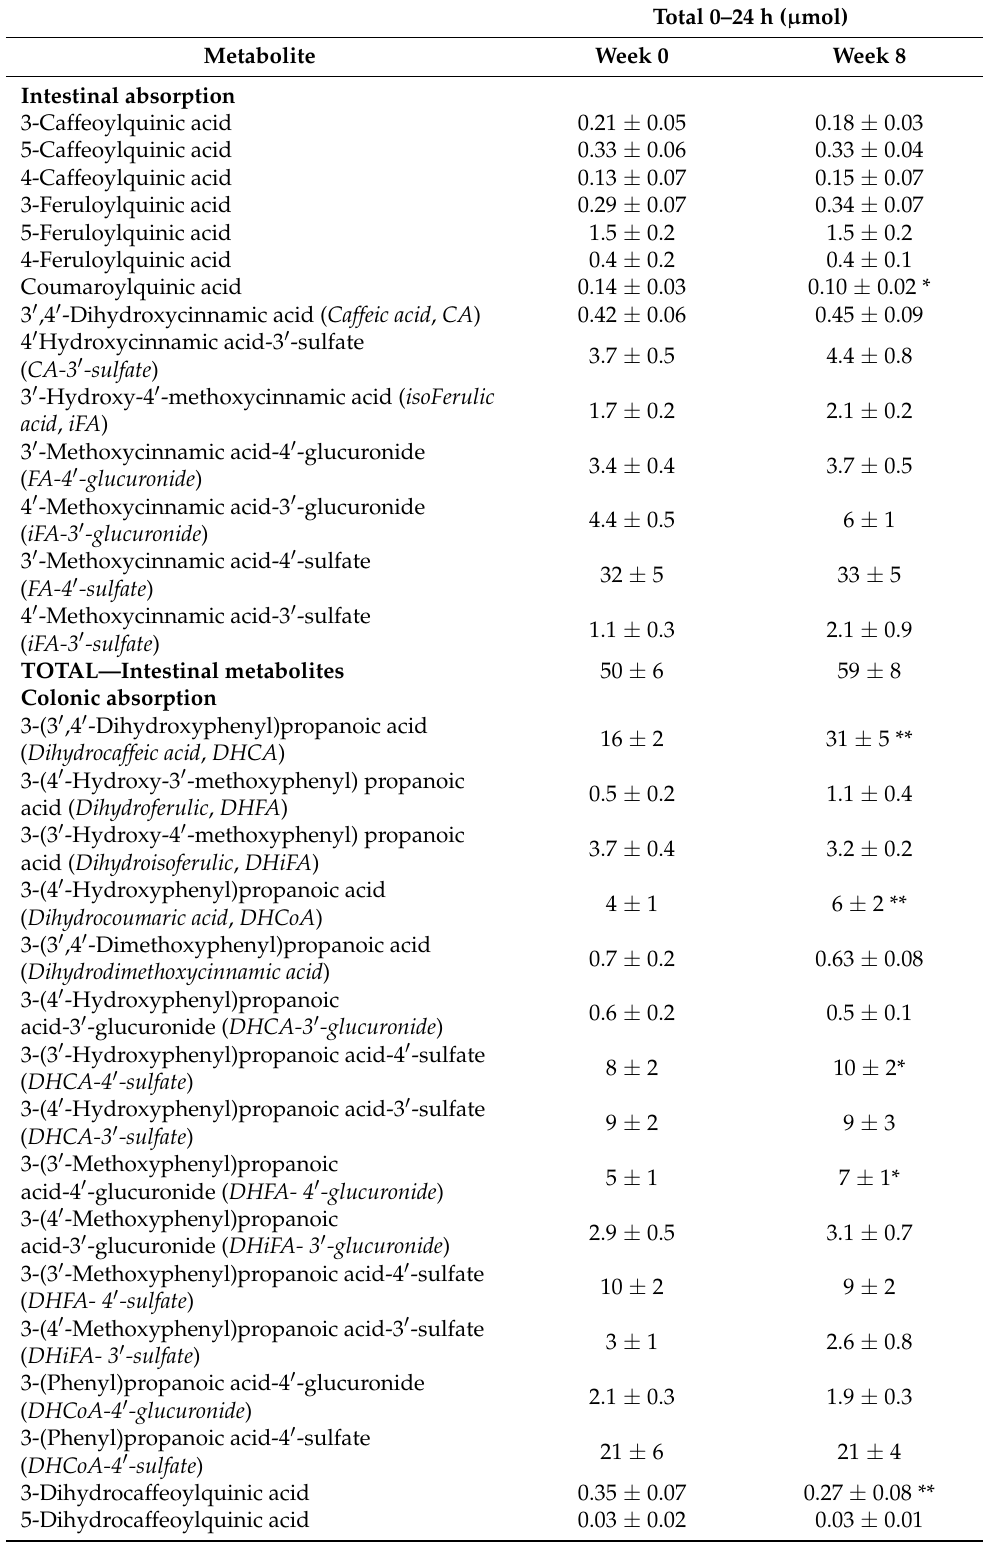
Table 2. Cumulative excretion (0–24 h) of urinary metabolites after the intake of GCPE nutraceutical at the beginning (week 0) and the end of the intervention (week